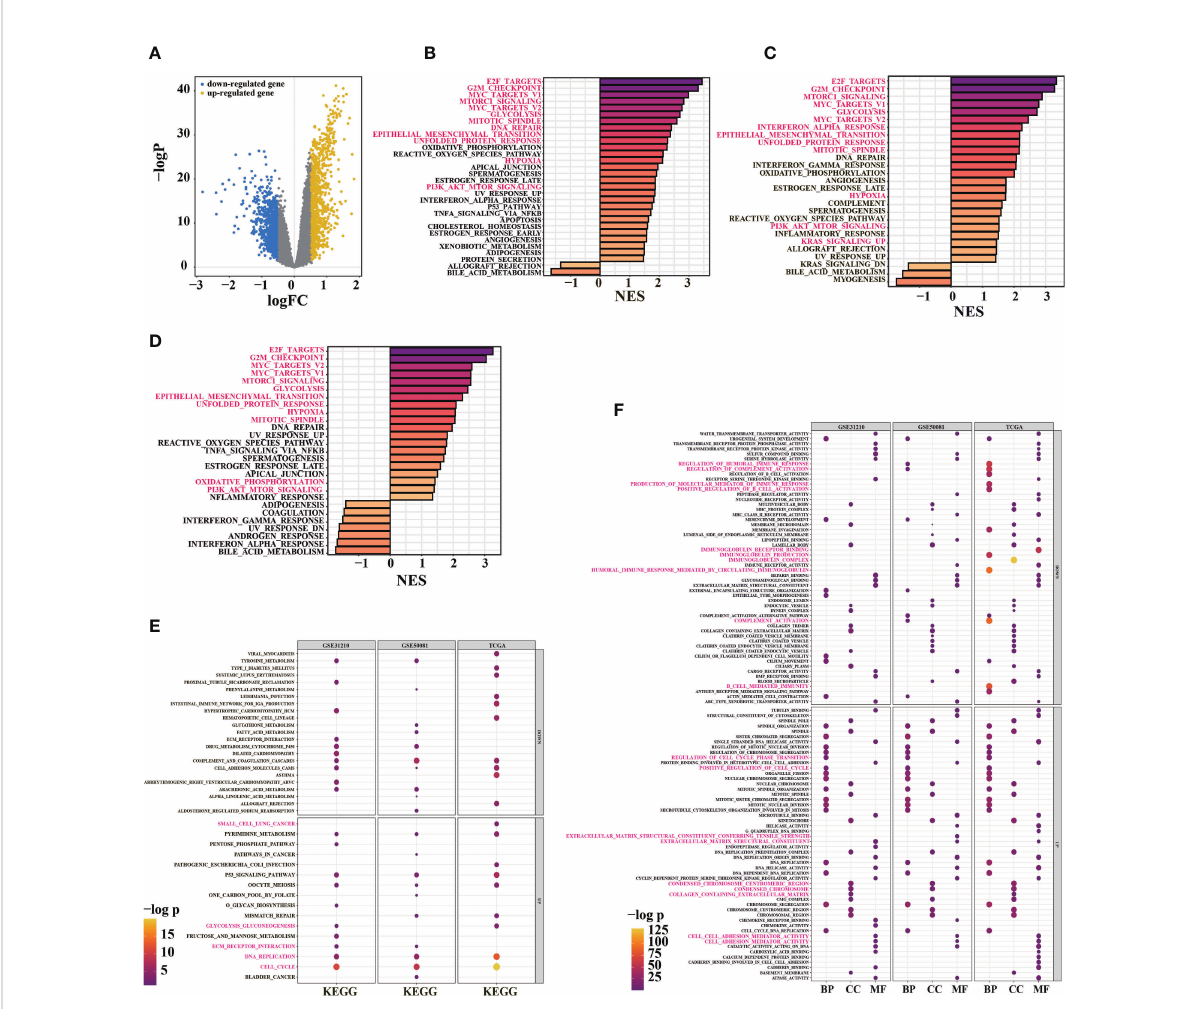
FIGURE 4 Functional enrichment analysis for prognosis signature. (A) volcano diagram show DEGs between high-risk and low-risk groups in TCGA-LUAD primary cancer samples. (B) GSEA enrichment analysis was performed using DEGs between high-risk and low-risk groups in TCGA cohort (30/ 50 genes were signi fi cant). (C) GSEA enrichment analysis was performed on the DEGs between high-risk and low-risk groups in the GSE31210 cohort (26/50 gene sets were signi fi cant). (D) 29/50 signi fi cant gene sets were obtained by GSEA enrichment analysis using DEGs between high-risk and low-risk groups in GSE50081 cohort (adj. pvalue< 0.05, color indicates the size of standardized enrichment score). (E) Based on LUAD samples in TCGA, GSE31210 and GSE50081 cohorts, the DEGs between high-risk and low-risk groups were analyzed for enrichment. Gene sets in KEGG database (E) and GO database (F) were used for enrichment analysis (FDR< 0.01; Color and dot size indicate enrichment signi fi